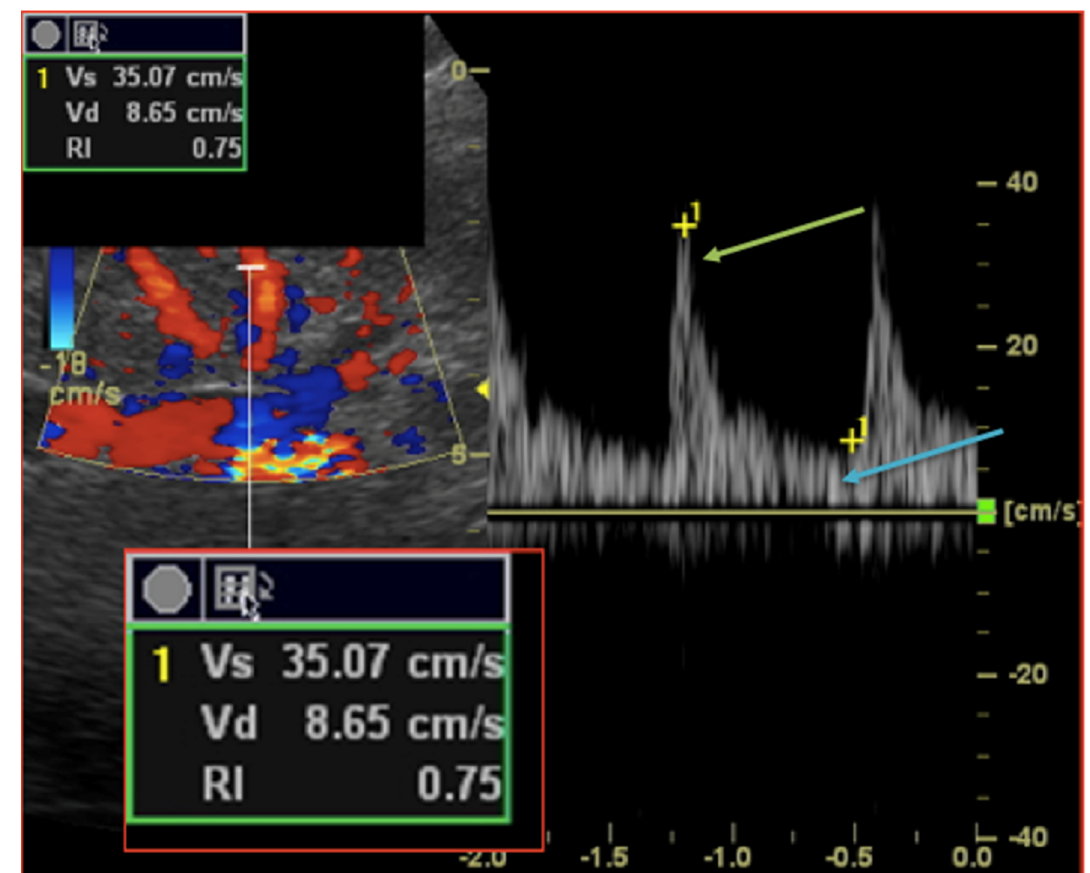
Figure 1. Intrarenal Doppler Ultrasonography: Renal Resistive index measurement technique. A sample volume is placed within an interlobar artery using Colour Doppler guidance. Spectral analysis of vascular signals is then obtained, and measurement callipers are set as follow: (i) systolic peak (green arrow); (ii) end diastole peak (blue arrow). Renal Resistive index is then calculated according to the formula (Vs – Vs)/Vs.